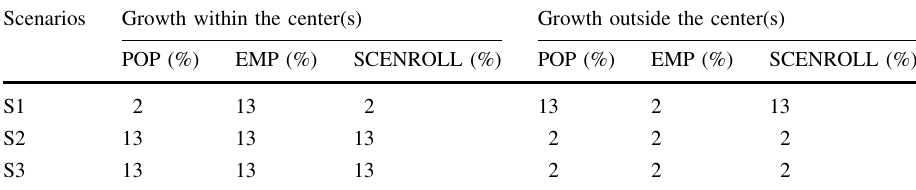
Table 1 Assumed changes in land use for each